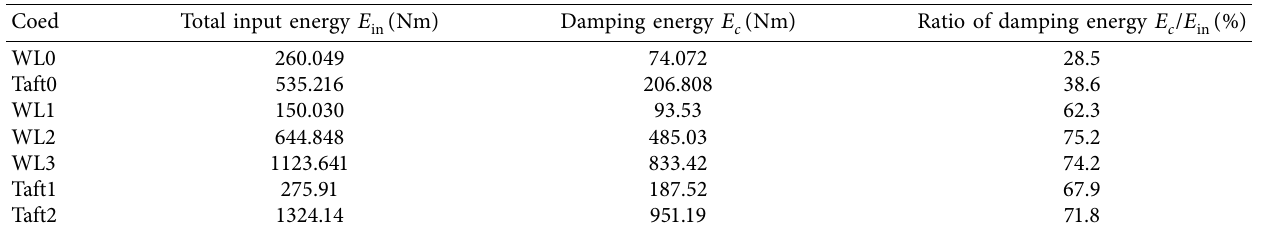
Figure 9: Curve of energy accumulation with time: (a) WL0, (b) Taft0, (c) WL1, (d) WL2, (e) WL3, (f) Taft1, and (g) Taft2. Table 4: Details of energy